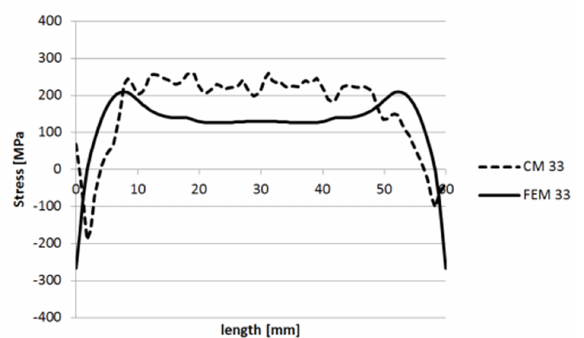
Figure 29. Stress levels in 33 direction along the AB line segment.